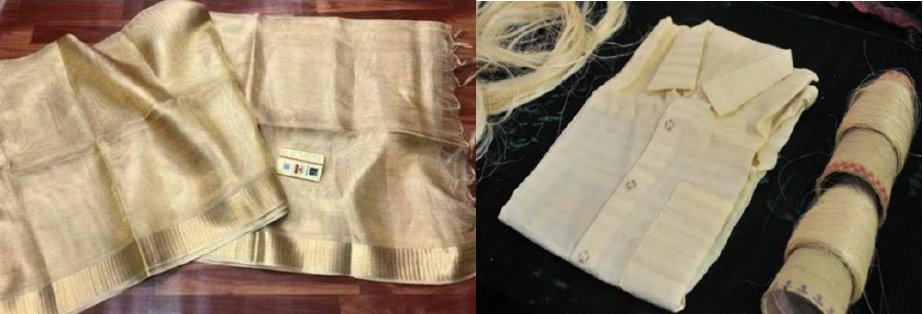
Figure 5. Traditional wares from banana silk [26].